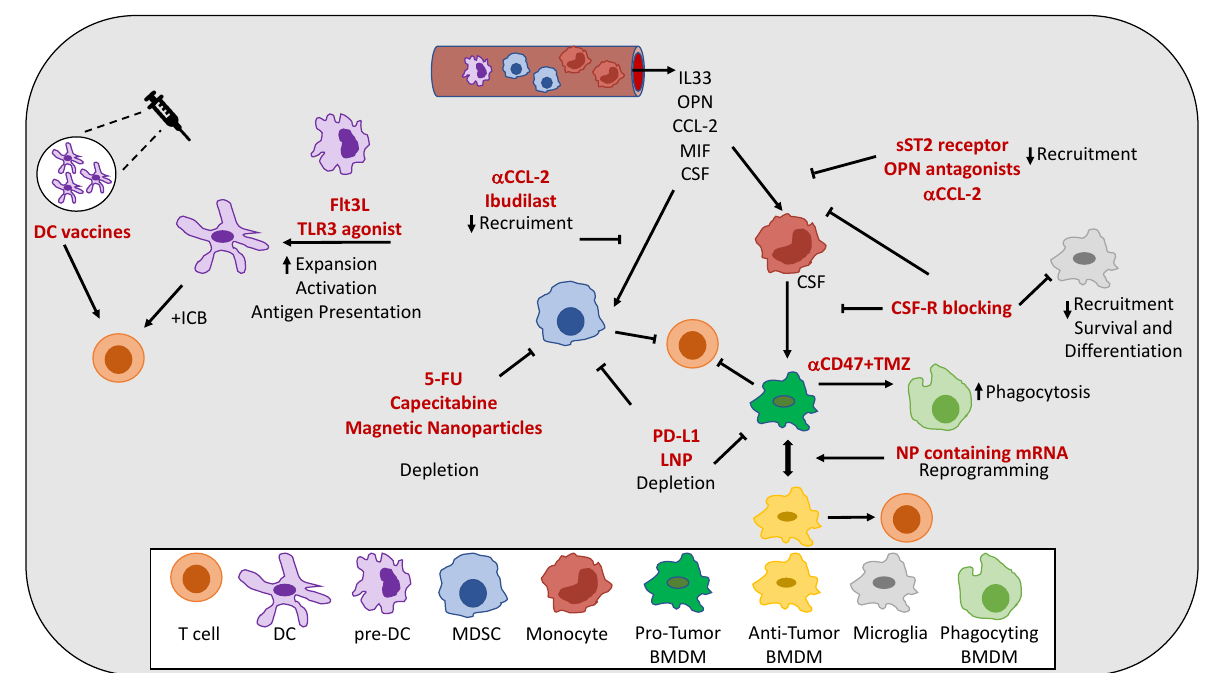
Figure 2. Targeting myeloid cells in GBM. Different approaches aimed to deplete and to inhibit functions and recruitment of MDSCs and TAMs are used to reduce the immunosuppression. DC vaccines and approaches aimed to increase accumulation, activation, and functions of DCs are used to stimulate effector